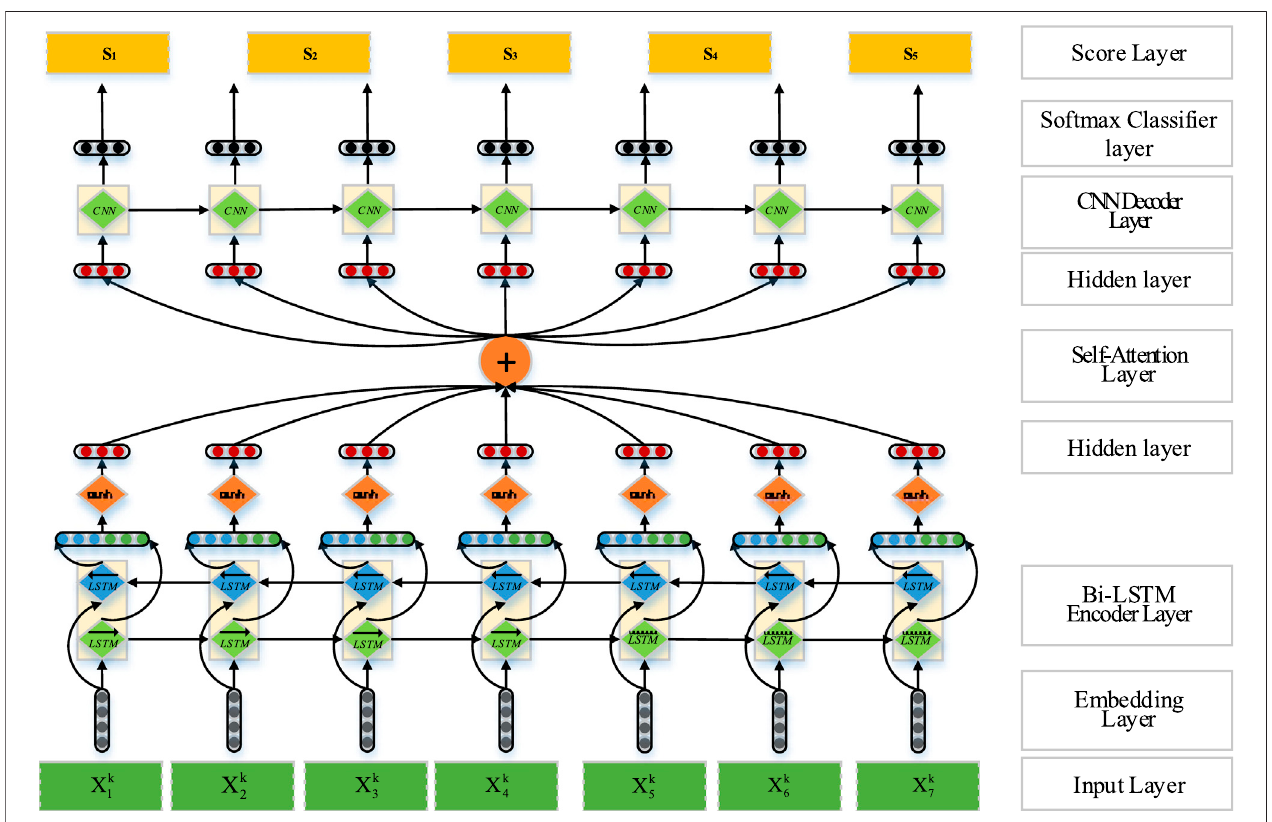
FIGURE 1 | Investment risk assessment model